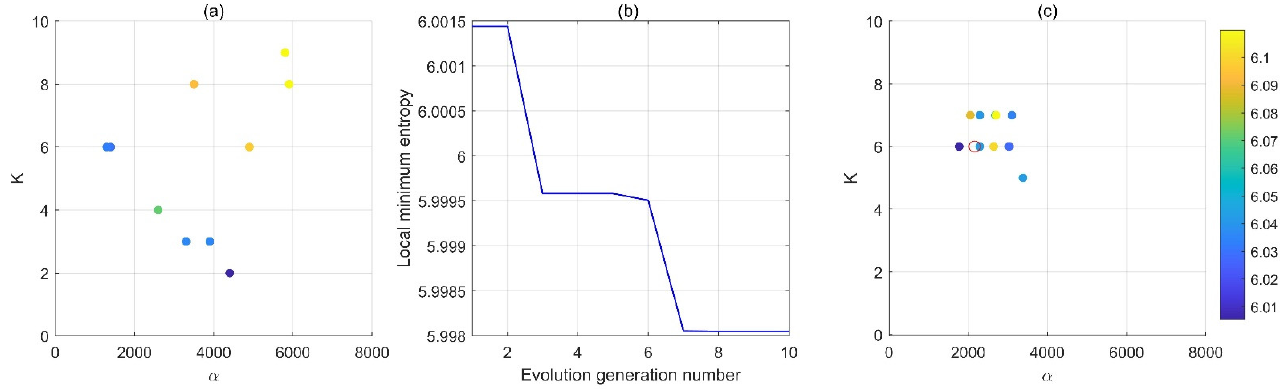
Figure 7. IMFs after VMD decomposition: ( a ) − ( f ) show IMF1 − IMF6, respectively. Table 1. RMSE and SNR of different IMFs combinations. No.